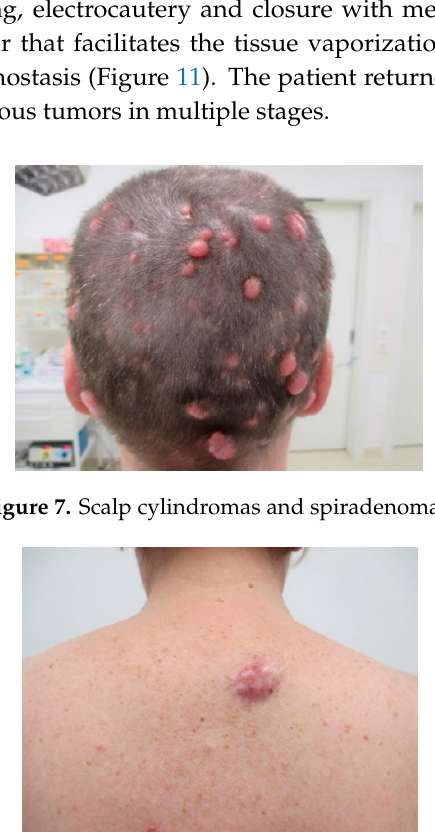
Figure 8. Cylindroma of the posterior thorax.